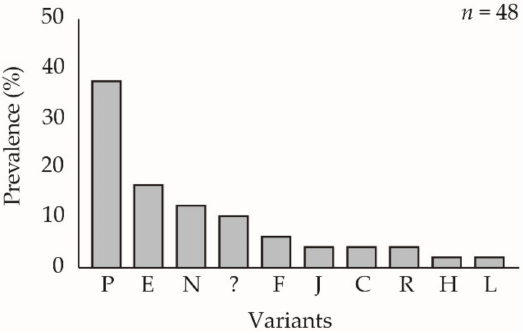
Figure 6. Prevalence of REN profiles from virus-killed larvae that were infected by injection of plaque picks derived from BVs in hemolymph samples obtained following inoculation of Chrysodeixis includens fifth instars with ChinNPV-K pure variant OBs. New genotypes whose REN profiles did not match any of the previous studied variants were included in an unknown group shown as “?”; n indicates the number of plaque picks used to inoculate insects. The y -axis indicates the prevalence (%) of insects that produced progeny OBs with a particular dominant REN profile and the x -axis indicates each of the observed REN profiles in decreasing frequency.